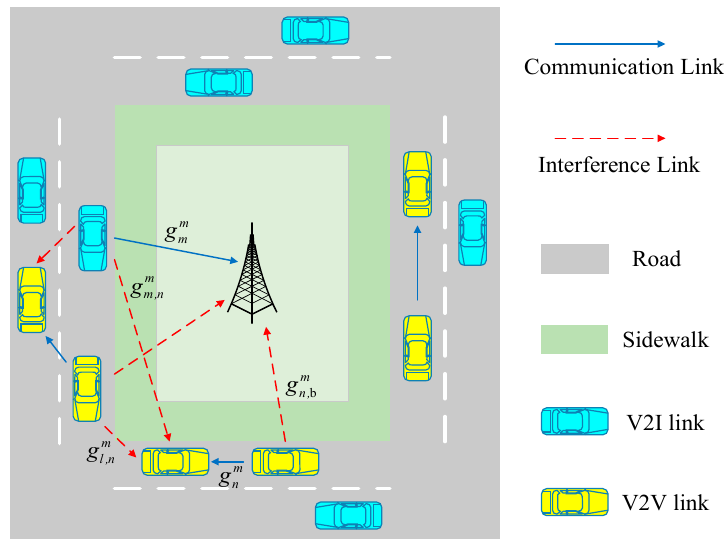
Figure 1. System model for vehicular communication underlaying cellular network in uplink.